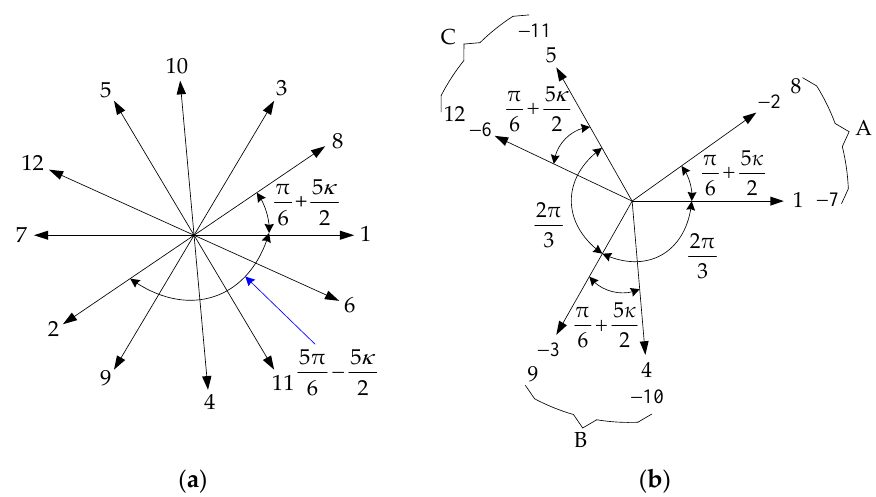
Figure 2. The star graph of the fundamental EMF and the diagram of phase separation: ( a ) The star graph of the fundamental EMF; ( b ) The diagram of phase separation.